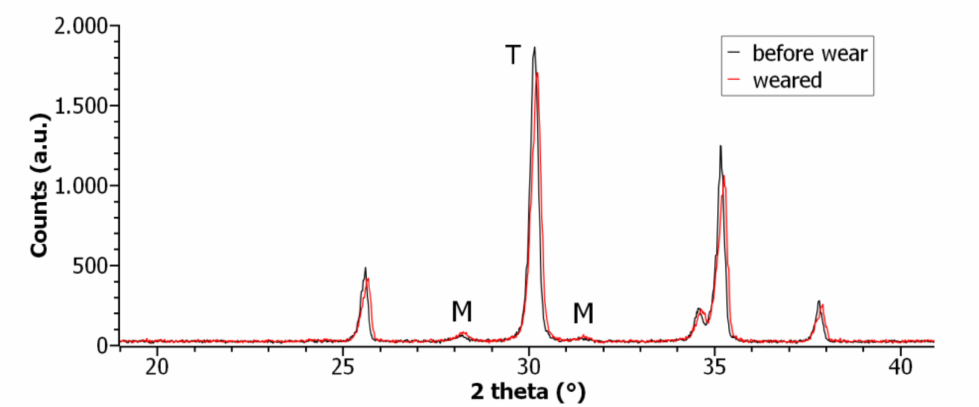
Figure 5. X-ray diffractograms obtained for ZTA femoral